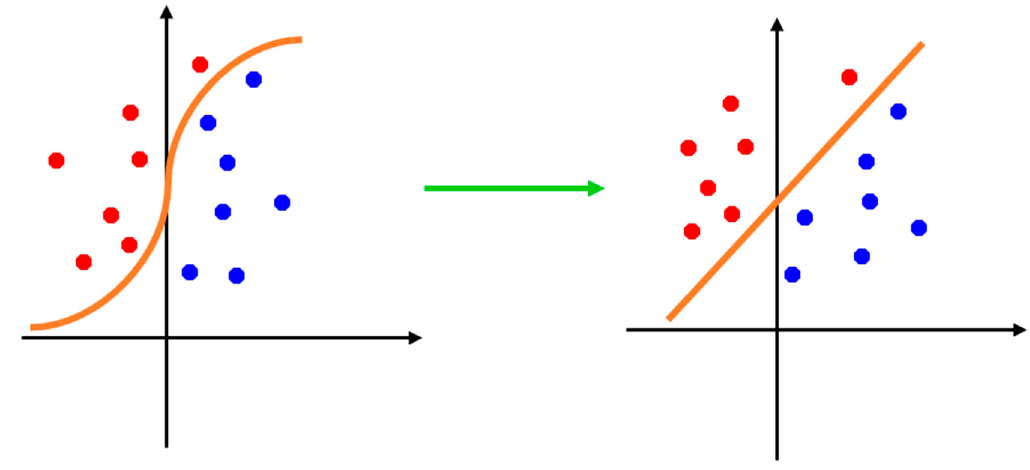
Figure 2. Nonlinear SVM [22].